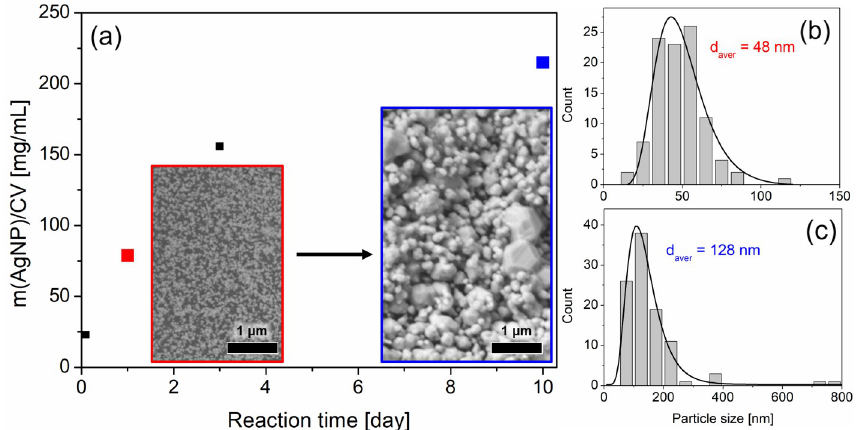
Figure 4. ( a ) Time-dependent growth of AgNP crystals on the surface. SEM images with the same scale for samples represented by the red and blue squares are shown for AgNP size comparison. ( b , c ) Corresponding size distributions determined from SEM images. The average diameter was determined from the fitted log-normal distribution curve. The maximal theoretical m(AgNP)/CV was ≈ 350 mg/mL. Samples were prepared with 4 mM H 2 SO 4 .